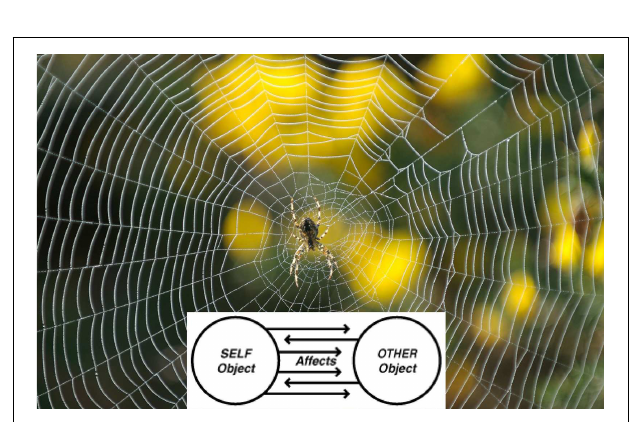
FIGURE 3 | Object relations and ecological